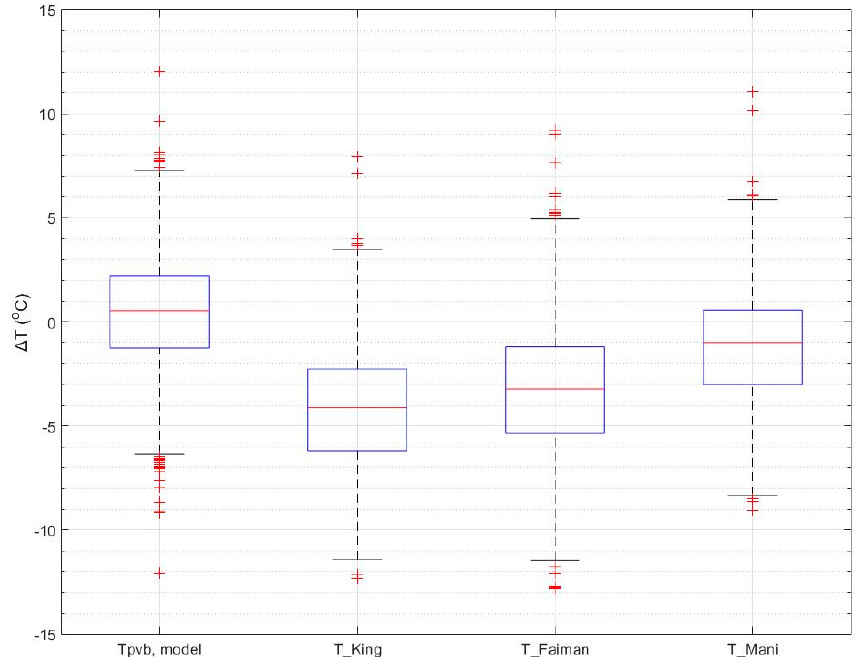
Figure 11. Boxplot of temperature difference ΔΤ between predicted and measured values for the proposed model in comparison to that of the other 3 models. Table 1. Δ Τ statistics between predicted and measured values for this model and the other 3 models.